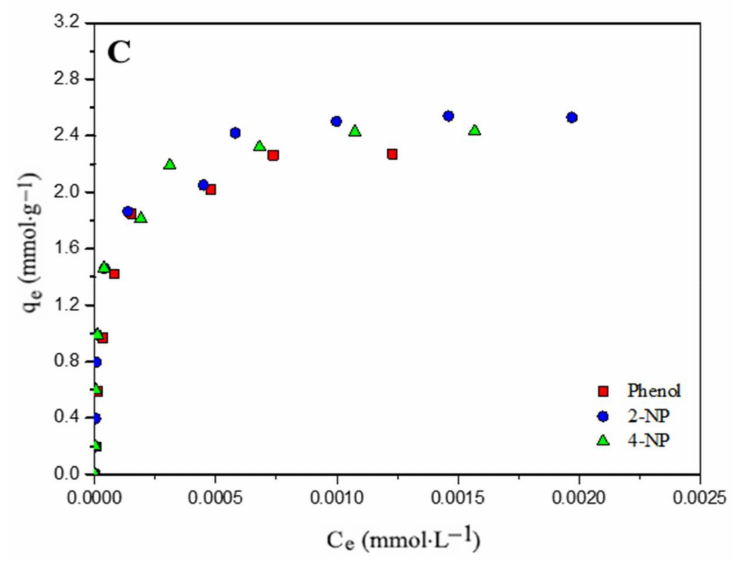
Figure 2. Adsorption isotherms for the removal of phenol, 2-NP, and 4-NP by DKLAAC at 25 ◦ C ( A ), 35 ◦ C ( B ), and 45 ◦ C ( C